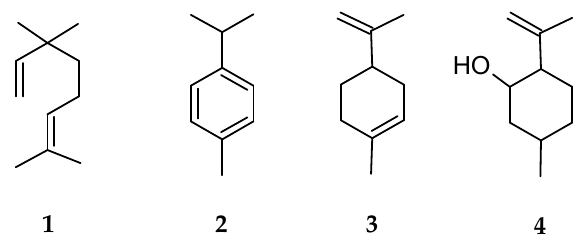
Figure 4. Chemical structures of linalool ( 1 ), p -cymene ( 2 ), limonene ( 3 ), and isopulegol ( 4